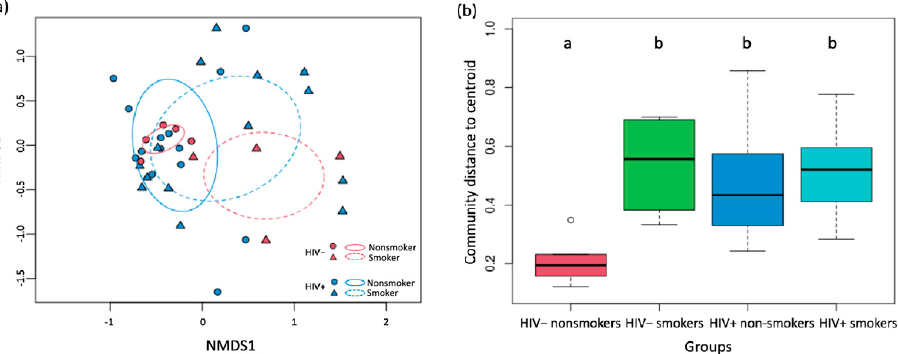
Figure 3. Non-metric multidimensional scaling ( a ) and within-group variation of lung bacterial community ( b ) across HIV and smoking status. In ( a ), samples from HIV- and HIV+ were colored in blue and red, respectively, and symbols for smokers and nonsmokers were circles and triangles, respectively. Ellipses (95% confidence intervals) were drawn around samples from the four groups. non-smokers for HIV- (red, p = 0.13) but not for PLWH (blue, p = 0.44). In ( b ),